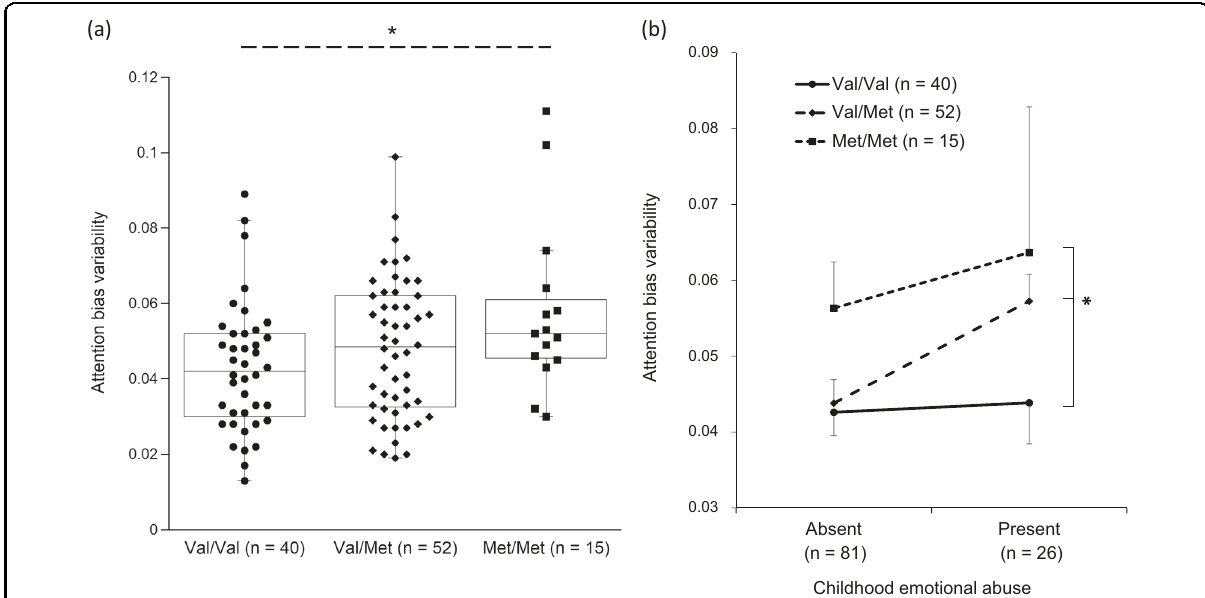
Fig. 2 Attention bias variability scores across the BDNF Val66Met genotype groups. a Combined dot- and boxplot comparing the attention bias variability scores between individuals with the Val/Val ( n = 40), Val/Met ( n = 52), and Met/Met ( n = 15) genotypes. *A signi fi cant trend toward greater attention bias variability with increasing numbers of Met alleles ( P = 0.021 by the Jonckheere – Terpstra trend test). b Interaction between the Val66Met genotype and childhood emotional abuse for the attention bias variability scores. Participants were grouped into those with childhood emotional abuse and those without, using the cutoff of 8/9 points for the Childhood Trauma Questionnaire emotional abuse. The solid line with circle markers is the Val/Val genotype, the broken line with diamond markers is the Val/Met genotype, and the dotted line with square markers is the Met/Met genotype. Error bars indicate SEM. *A signi fi cant genotype-by-maltreatment interaction ( P = 0.022 by the two-way